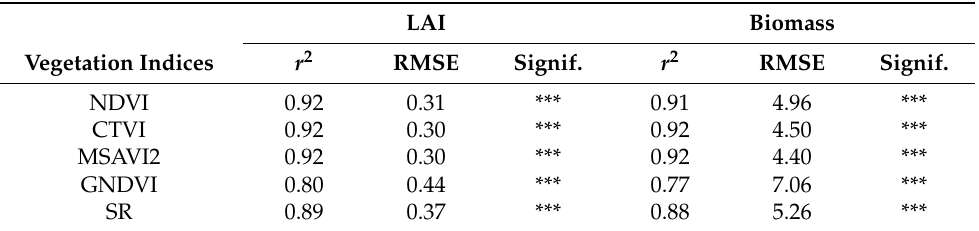
Table 4. Correlations accuracies between predicted Leaf area index (m 2 m − 2 ) and shoot biomass (g per plant) using calibration models and the measured data in the 2019 validation field trial (n = 60).